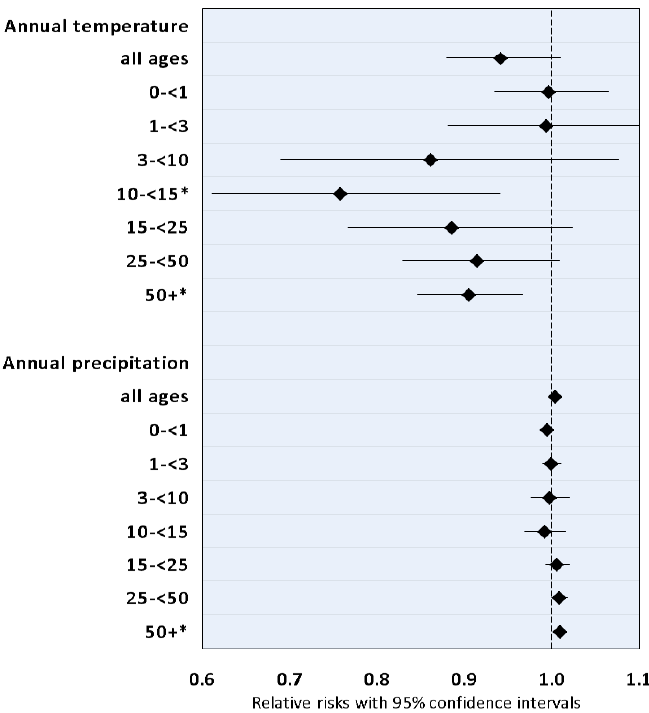
Figure 4. Association between annual climate variability and annual age-stratified mortality, Skellefteå